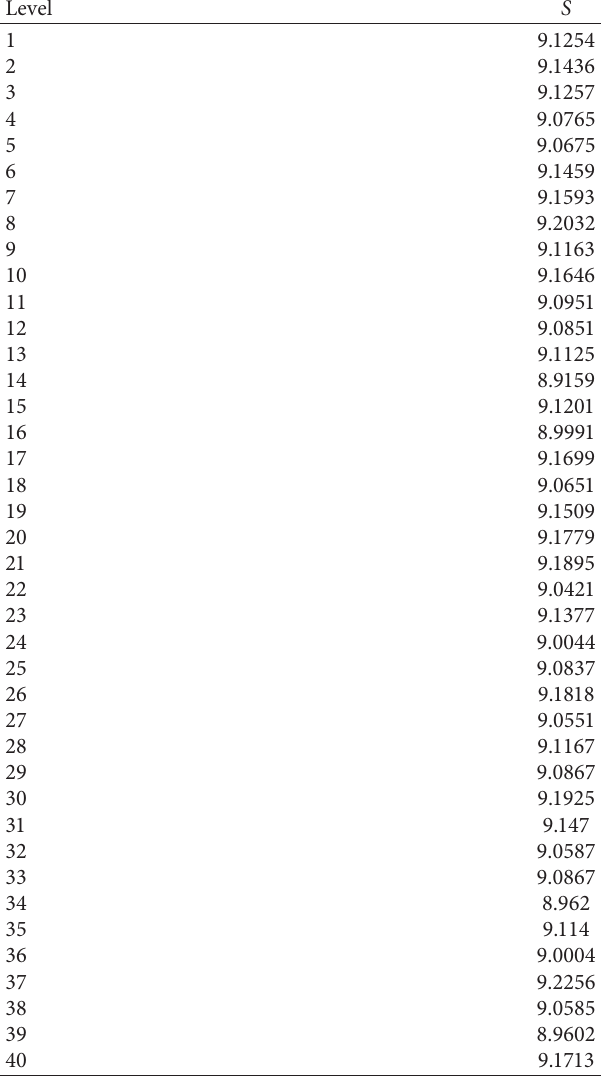
Table 10: Efficiency-house of